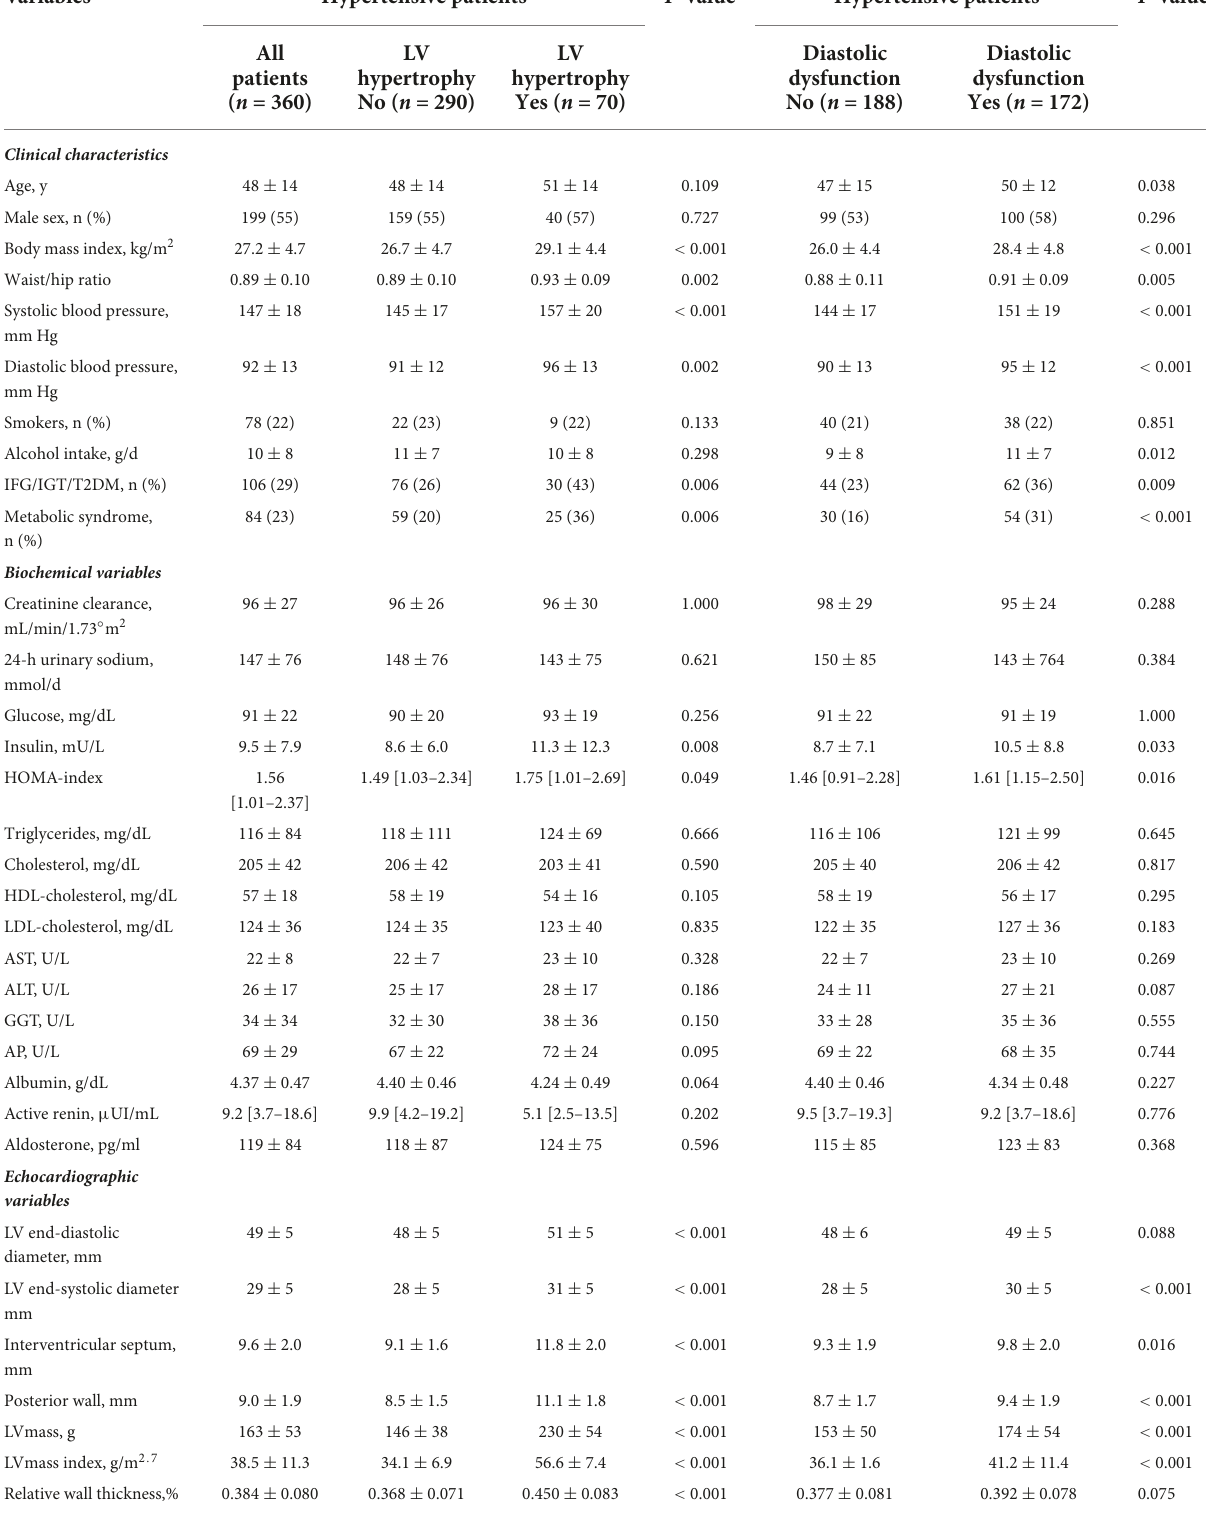
TABLE 2 Clinical characteristics and biochemical and echocardiographic variables of hypertensive patients who were grouped according to presence or absence of left ventricular hypertrophy or according to presence or absence of left ventricular diastolic dysfunction.